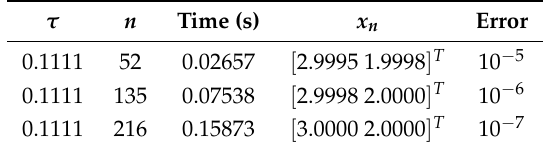
Table 1. x 0 = rand ( 2,1 ) , results without bounded